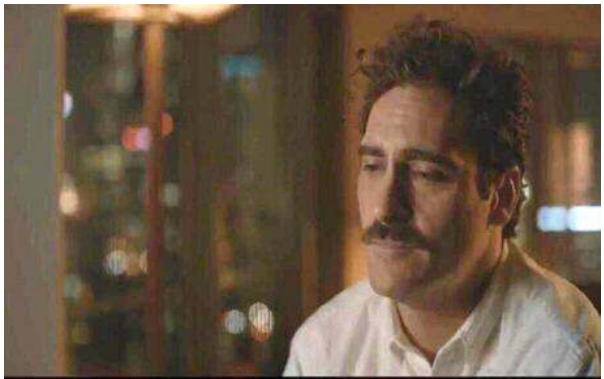
Figure 1. Theodore apologizes to